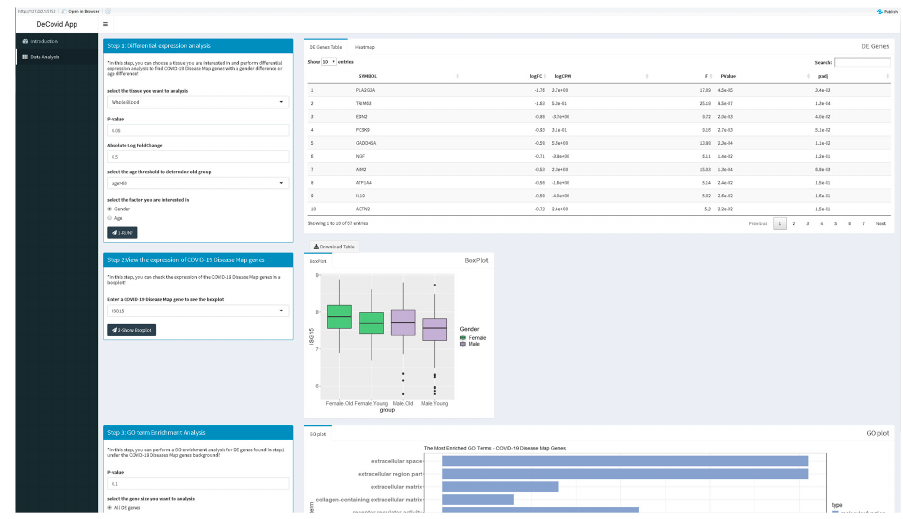
Figure 2. Screenshot of the DeCovid app showing the left dialog panels for input parameters (contrast type and significance thresholds), and on the right results panels with a list of di ff erentially expressed genes, gene-specific expression plots and enrichment analysis.